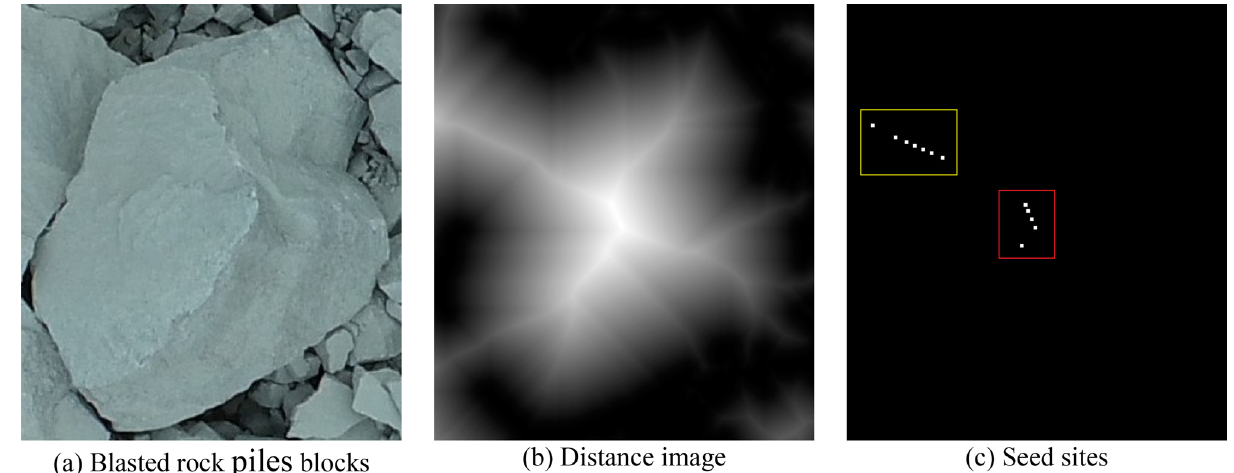
Figure 9. Detailed image of distance transformation and seed point image of rock block.